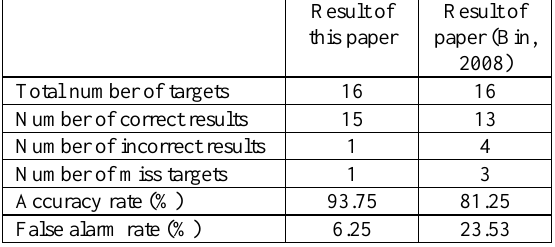
Figure 4. Another point cloud data to be identified